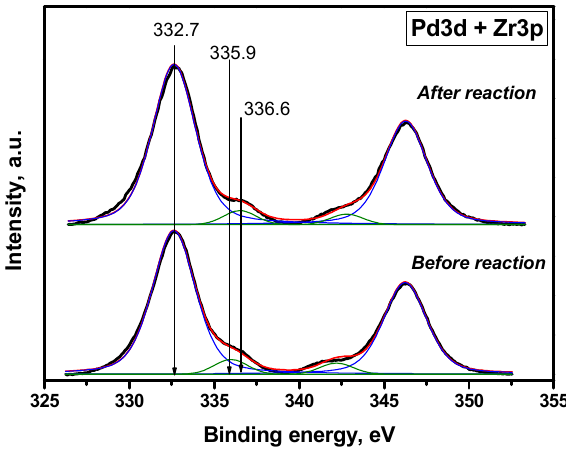
Figure 10. X-ray photoelectron spectroscopy spectra (Zr3p and Pd3d) of 2% Pd/ZrO 2 (before and after catalytic cycles). Table 3. Atomic ratio of elements in 2%Pd/ZrO 2 catalyst identified by X-ray photoelectron spectroscopy.